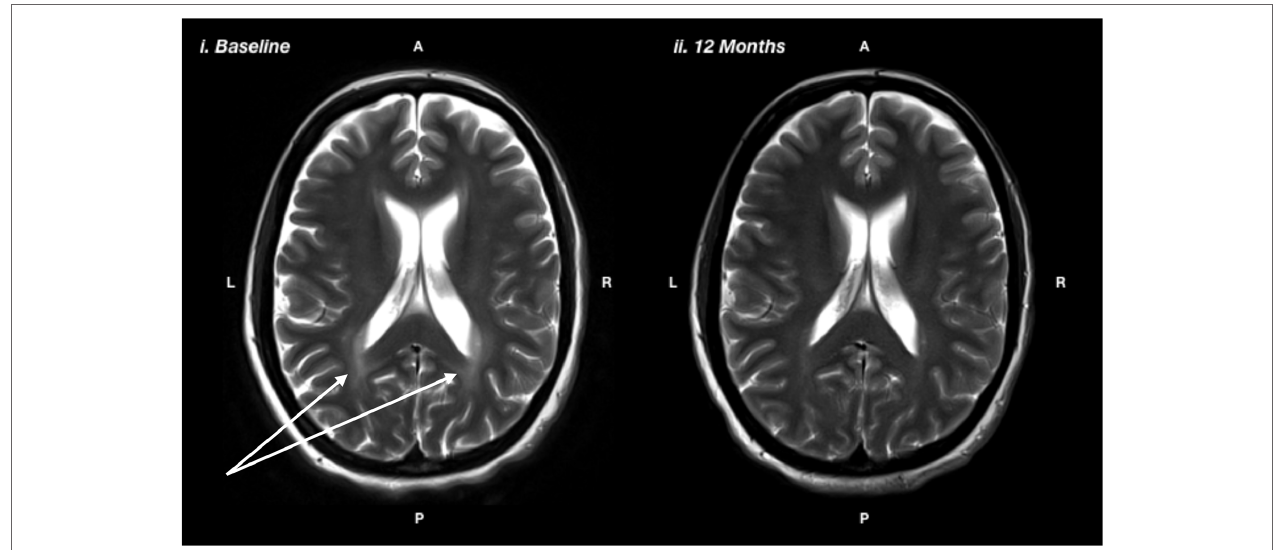
FIGURE 3 | T2-weighted magnetic resonance imaging showing i) baseline: prior to the recommencing diet, and ii) 12 months after recommencing diet, showing reduction in white matter hyperintensity, particularly in the posterior regions, as indicated by the white